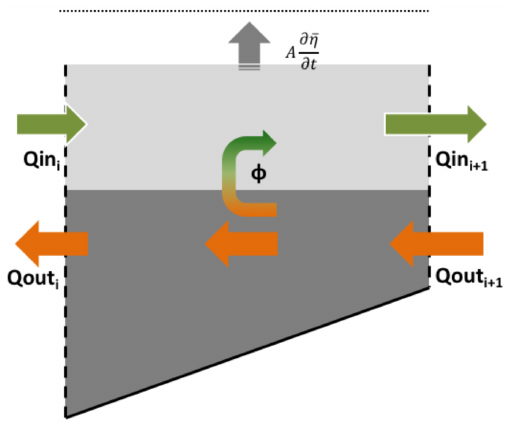
Figure 2. Diagram of the volume control used to estimate the ver- tical transfers ( (cid:56) ) of water between the inflow and outflow layer. Q in and Q out denote the horizontal transport towards the Mediter- ranean and towards the Atlantic Ocean at two cross-strait sections, ( i ) and ( i + 1). A ∂η represents the inflow layer volume change asso- ∂t ciated with vertical displacements of the mean sea surface elevation between the two